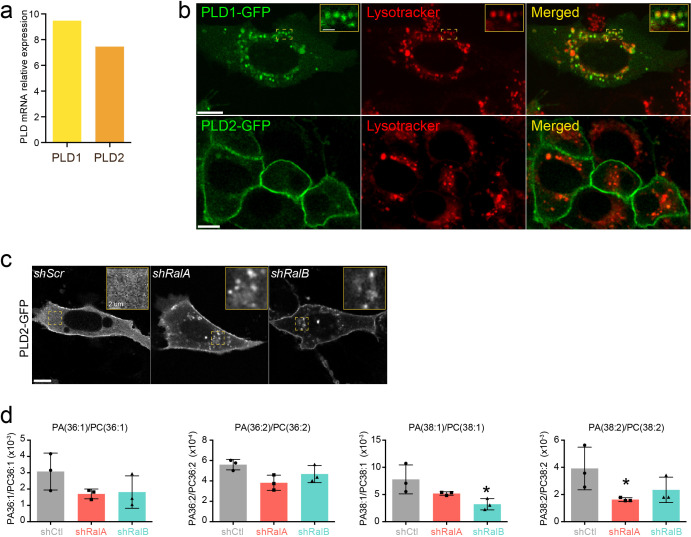
PLD1 and PLD2 in 4T1 cells.(a) PLD1 and PLD2 expression in 4T1 shControl cells quantified by qRT-PCR and normalized by gapdh expression. (b) Representative confocal images showing PLD1-GFP and PLD2-GFP subcellular localization in 4T1 cells stained with lysotracker. Scale bars: 10 μm (c) Representative confocal images of PLD2-GFP localization in shControl, shRalA, and shRalB cells. Scale bar: 10 μm (d) PA/PC ratio of species known to be targeted by PLD1 identified in extracellular vesicles (EVs) isolated from shControl, shRalA, and shRalB cells. Each dot represents one experiment; three independent experiments.